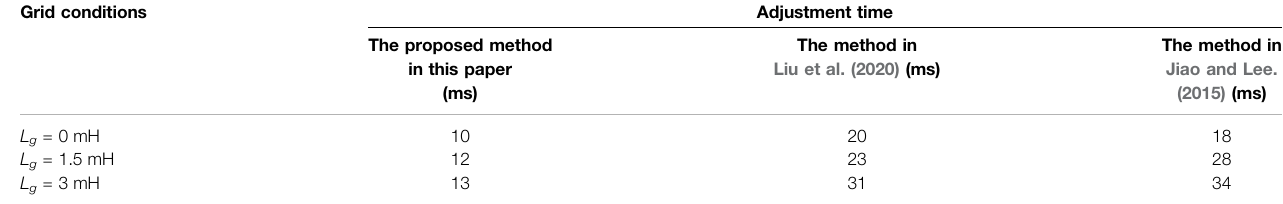
TABLE 3 | Comparison of dynamic performances with the three methods. Grid conditions Adjustment